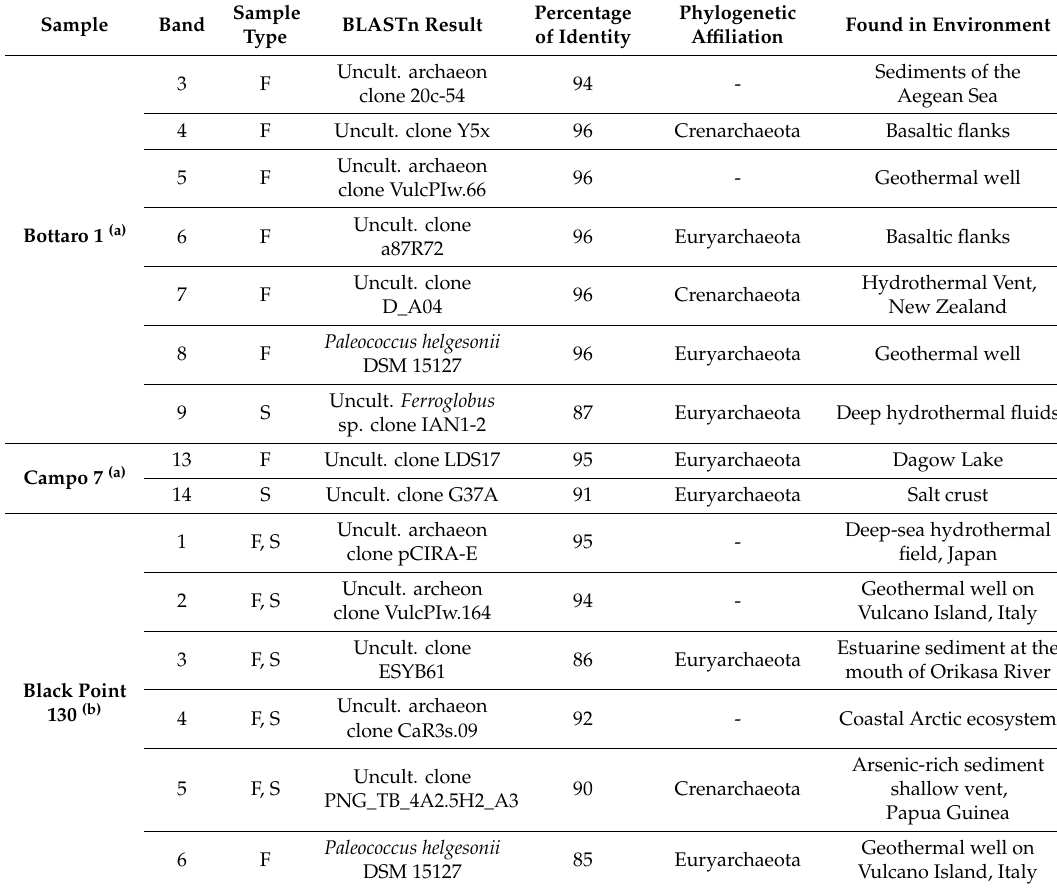
Table 5. Archaeal distribution arranged by samples collected from Bottaro, Campo 7, and Black Point vent sites, at Panarea system and sample type (F: fluid and S: sediment), as elucidated by PCR / DGGE